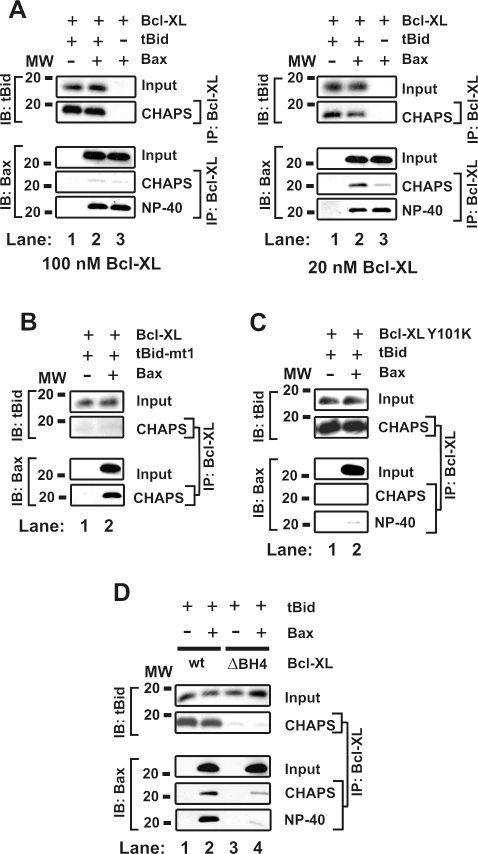
Bcl-XL Binds to Membrane-Bound tBid and Bax(A) Bax (100 nM) and/or tBid (20 nm) were incubated with 100 nM Bcl-XL (left panel) or 20 nM Bcl-XL (right panels) and liposomes. Samples were immunoprecipitated (IP) in either 2% CHAPS or 0.2% NP-40, as indicated, using an antibody with the indicated specificity and immunoblotted (IB) for the indicated protein.(B–D) Mutations prevent the binding of Bcl-XL to tBid, Bax, or both. (B and D) Bcl-XL (20 nM), or the indicated Bcl-XL mutants, (C) Bcl-XL Y101K or (D) Bcl-XL ΔBH4, were incubated with (C and D) 20 nM tBid or (B) tBid-mt1 with or without Bax (100 nM) and with liposomes. Immunoprecipitations and immunoblotting were performed as in (A).